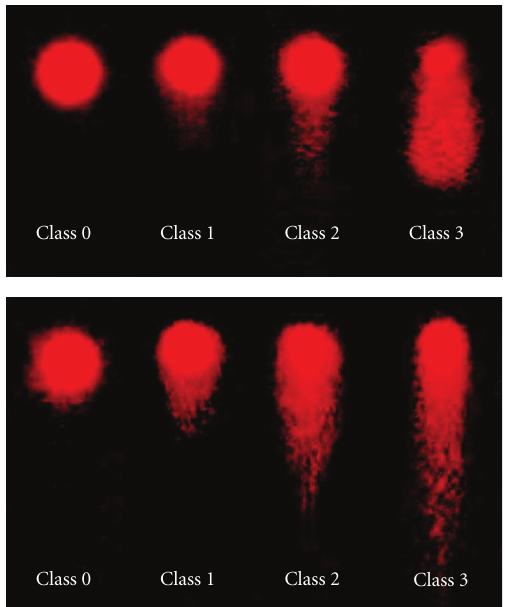
Figure 1: Classification of the comets. Normal nucleus (class 0), halo around the nucleus (class 1), and gradual increase in the length of the comet tail, evolving in parallel with a decrease in the nuclear DNA content (class 2 and class 3). Alkaline comet assay reflecting global DNA damage (ssb + dsb) (upper panel), and neutral comet assay reflecting dsb mainly (lower